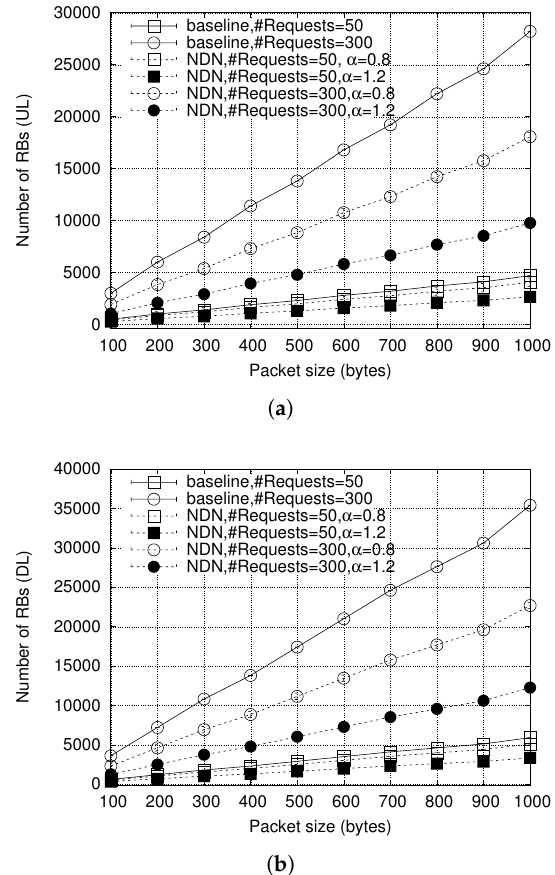
Figure 4. Number of RBs per Interests vs. Interest packet size values, when varying the number of requests issued by the consumers and the Zipf’s parameter α of our proposal against a baseline non-NDN approach: ( a ) UL (MCS = 11); and ( b ) DL (MCS = 8).